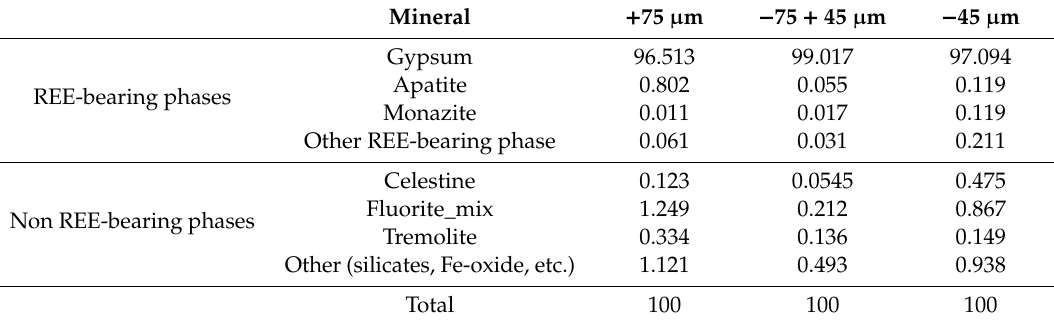
Table 9. Modal mineralogy of the PG sample (wt. %).